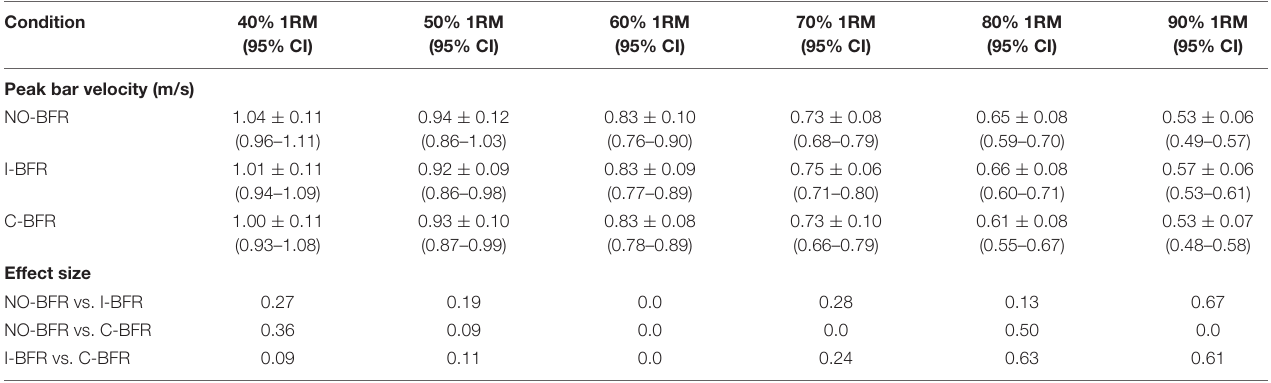
TABLE 1 | Mean bar velocity during the bench press exercise for six different loads.